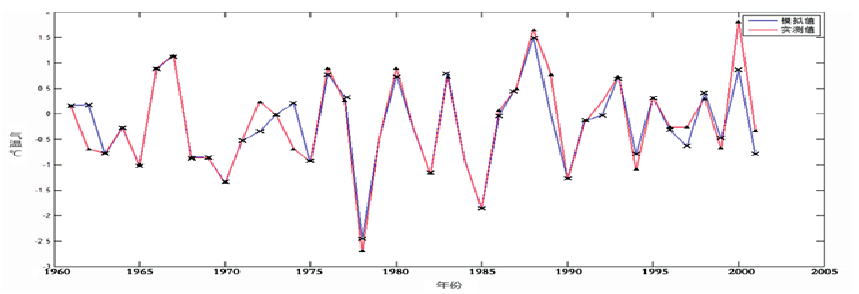
Fig. 1 Optimal temperature simulation based on PSO.